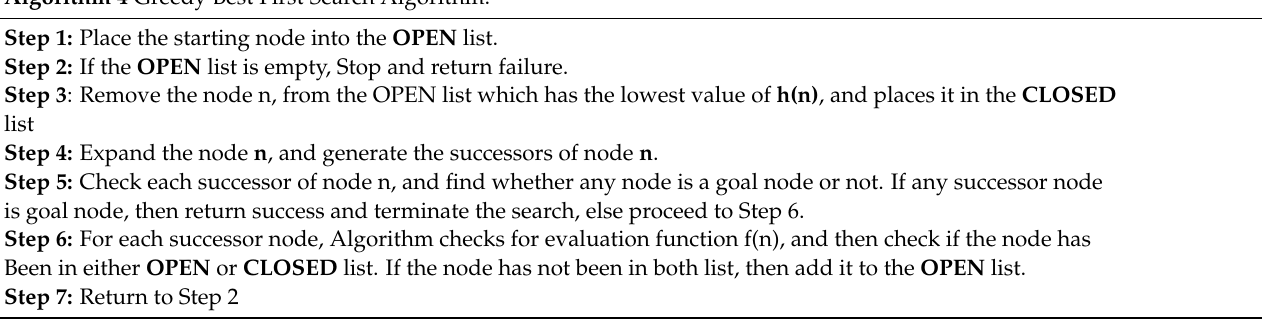
Algorithm 4 Greedy Best First Search